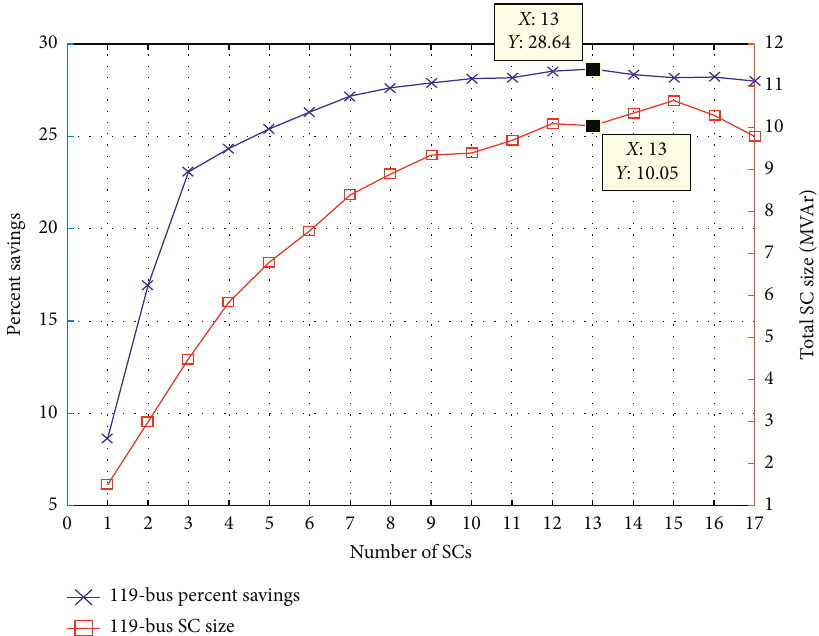
Figure 16: Effect of different numbers of SCs on performance of 119-bus